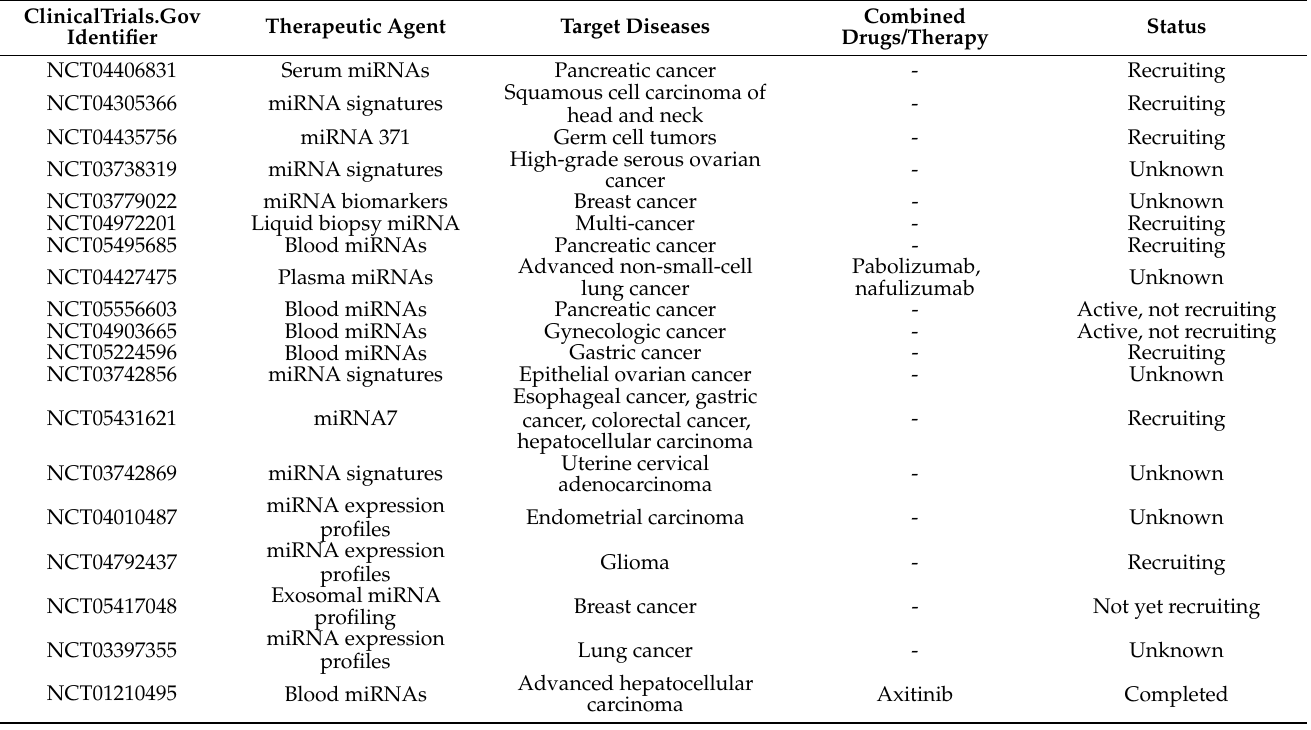
Table 4. miRNA and terminated replacement therapy and profiling studies in clinical trials. ClinicalTrials.Gov